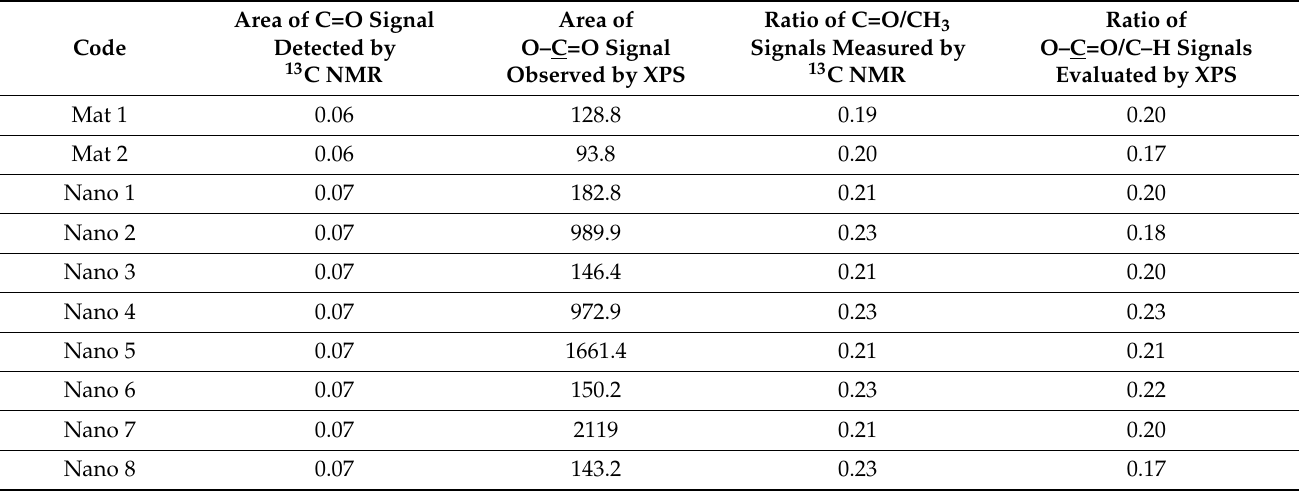
Table 3. Comparison of copolymer and nanocomposites materials’ areas obtained by 13 C-NMR and XPS techniques.